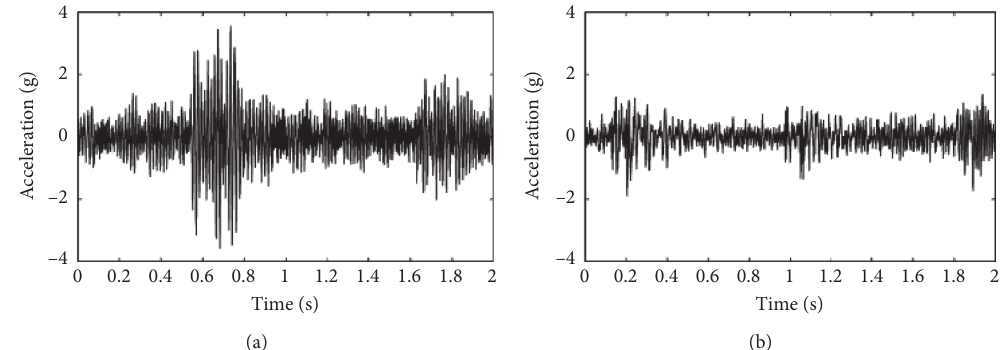
Figure 5: The original acceleration signals of bogie frames under the train speed of 115km/h. (a) The motor bogie frame and (b) The trailer bogie frame.